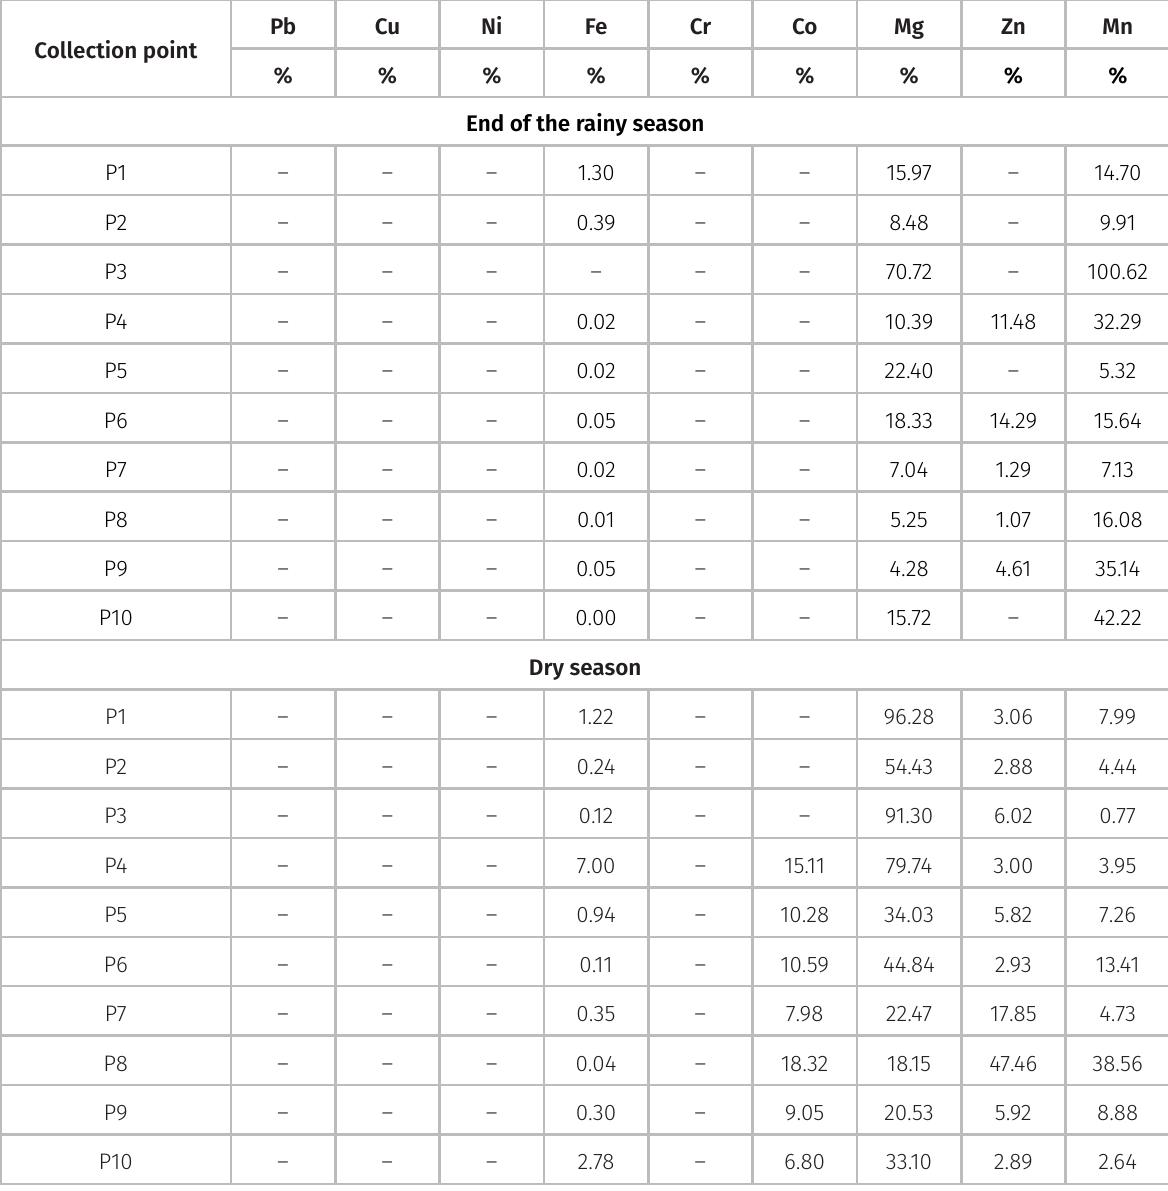
Table VI. Comparison of the average mobility (AM) of the extracted metals in the sediments of the Jequiezinho River in relation to the collection